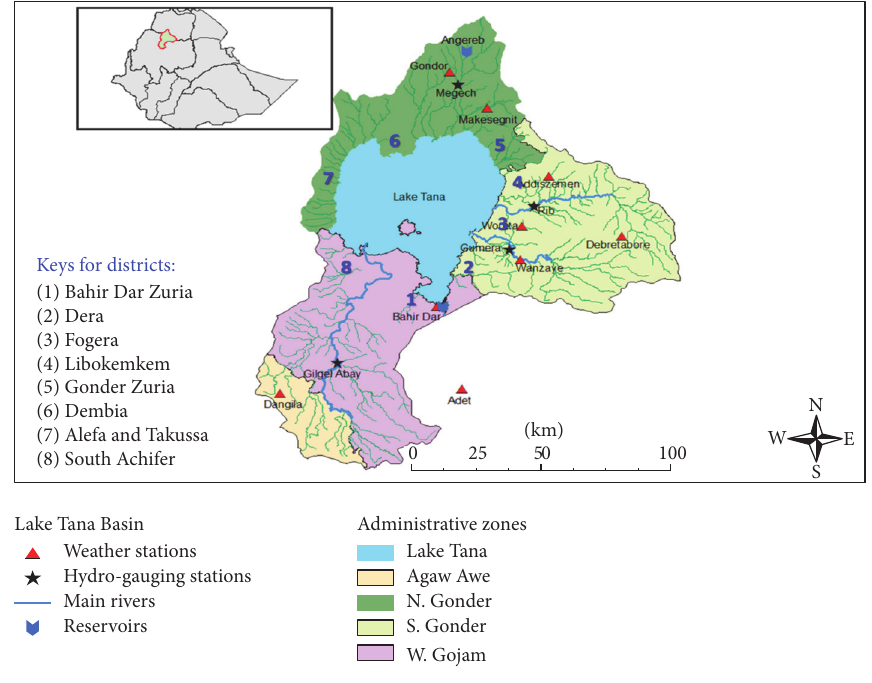
Figure 1: Districts of Fogera cattle breed distribution.